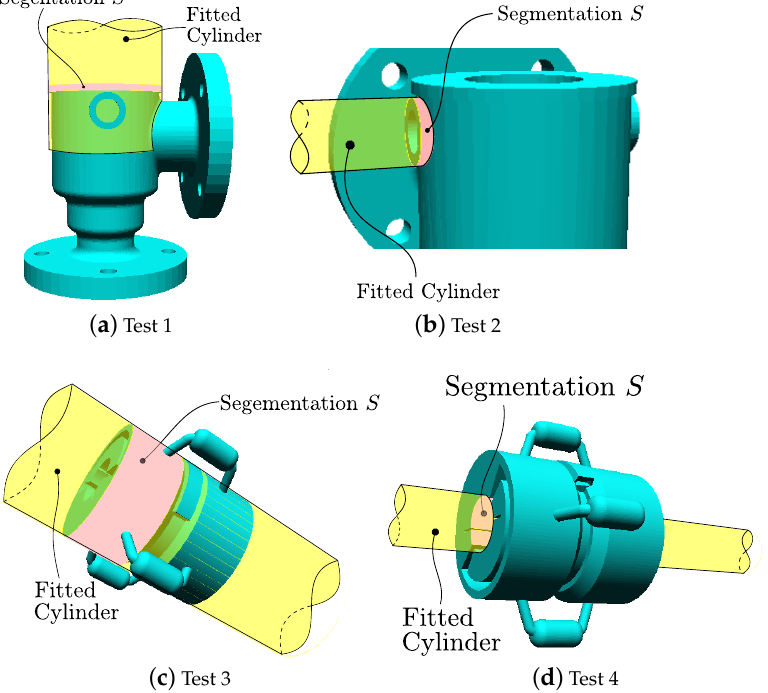
Figure 19. Cylinder fit. S extraction based on dihedral angles. Pink: extracted S support subset. Yellow: fitted g ()